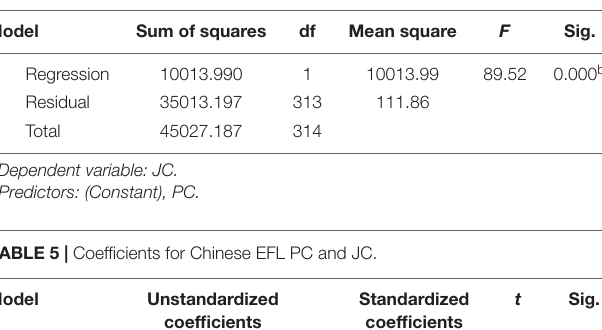
TABLE 4 | ANOVA for Chinese EFL PC and JC.